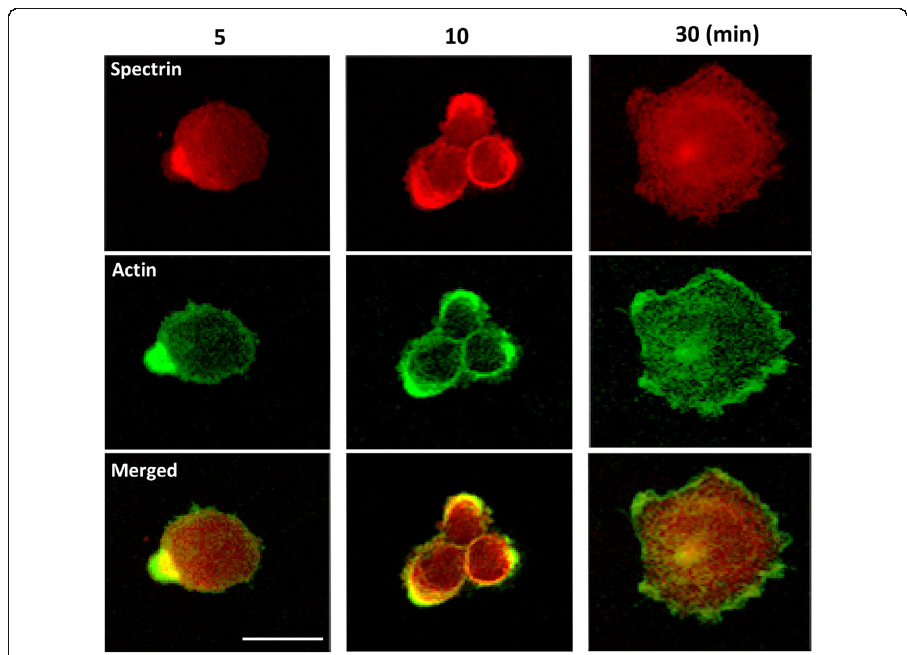
Fig. 3 α II-spectin is present in cell budding during adhesion. HMEC-1 cells were fixed at 5, 10 and 30 min after seeding on fibronectin. α II-spectrin was labeled with polyclonal antibody (red) and actin with phalloïdin toxin (green). Scale bar = 10 μ